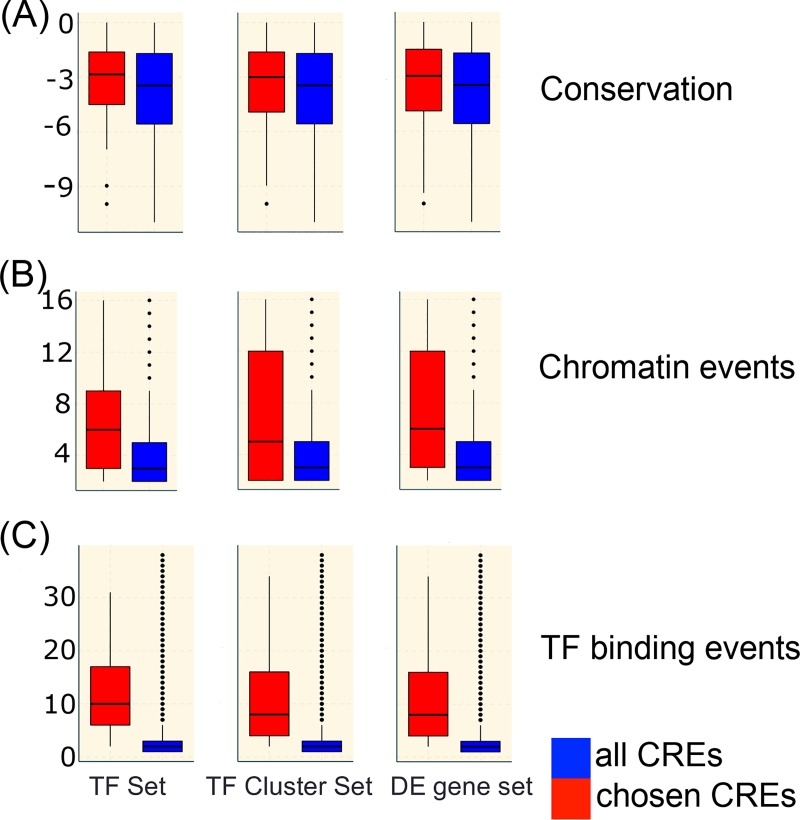
Characteristics of chosen regions.Conservation, chromatin events and TF binding events in chosen CREs (red) compared to all candidate CREs (blue). Left is the TF gene set, middle the TF cluster set and right all differentially expressed genes (DE set). (A) The log of the phylogenetic conservation scores (see Methods), (B) the chromatin events (H3K27Ac peaks and DHS), and (C) TF binding events. The p values were obtained using student t-test for conservation and Kolmogorov-Smirnoff test for chromatin and binding events. All the p values were less than 0.01 except for conservation distribution in TF set (p = 0.07).